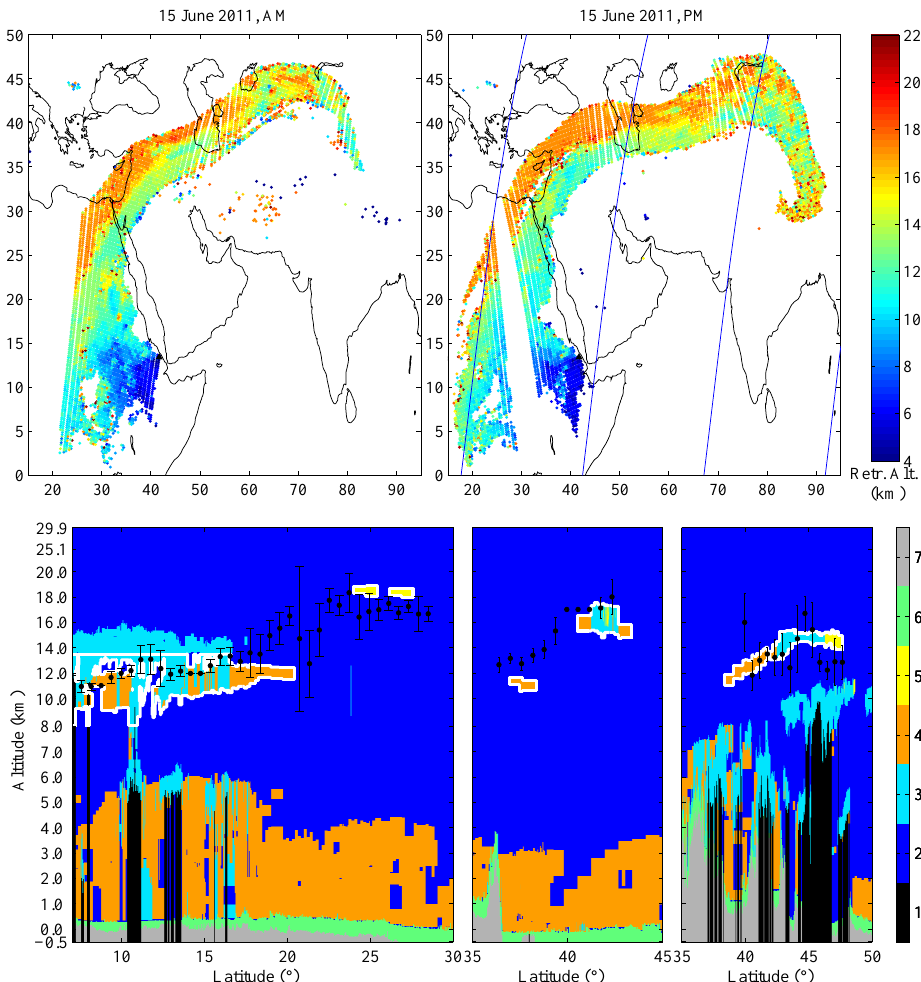
Fig. 6. IASI SO 2 height retrievals are presented on top from 4 to 22km; blue lines indicate CALIPSO ground tracks within 5h of the plume. In the bottom panels, the CALIOP the Level 2 product, “Vertical Feature Mask” is shown for the CALIPSO curtains corresponding to the ground tracks shown above, from left to right. Colours are numbered 1 to 7 indicated in the colour bar and stand for: no signal (1), clean air (2), cloud (3), aerosol (4), stratospheric feature (5), surface (6) and subsurface (7). Features which are likely to correspond to sulfate aerosols originating from Nabro are contoured in white on the CALIOP maps. Coincident IASI altitude retrievals are superimposed on these CALIOP maps as black dots, with a standard deviation representing the spread in retrieved altitudes around the